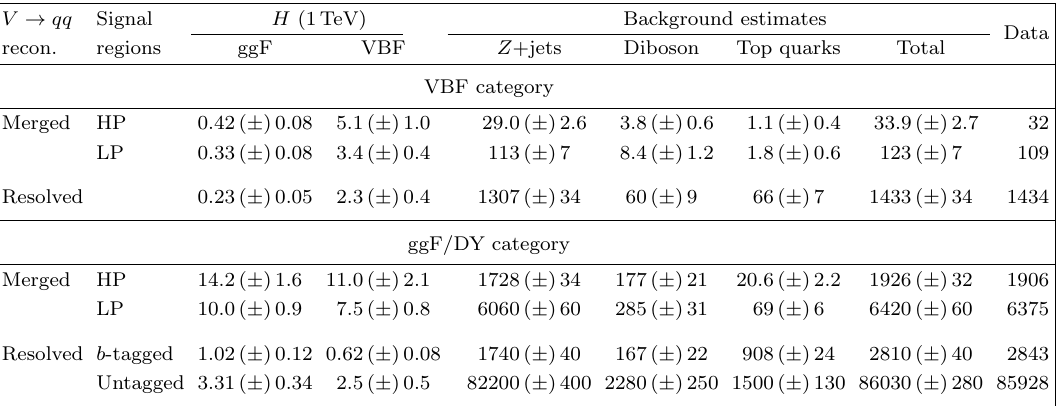
Table 2 . Numbers of events observed in the data and predicted for background processes from background-only (cid:12)ts to the signal and control regions (section 8) in the seven signal regions of the H ZZ ‘‘qq search. The numbers of signal events expected from the ggF and VBF production ! ! of a heavy Higgs boson with mass of 1 TeV are also shown. The signal yields are calculated using (cid:27) ( H ZZ ) = 20 fb for both processes. The uncertainties combine statistical and systematic (cid:2) B ! contributions. The (cid:12)t constrains the background estimate towards the observed data, which reduces the total background uncertainty by correlating those from the individual